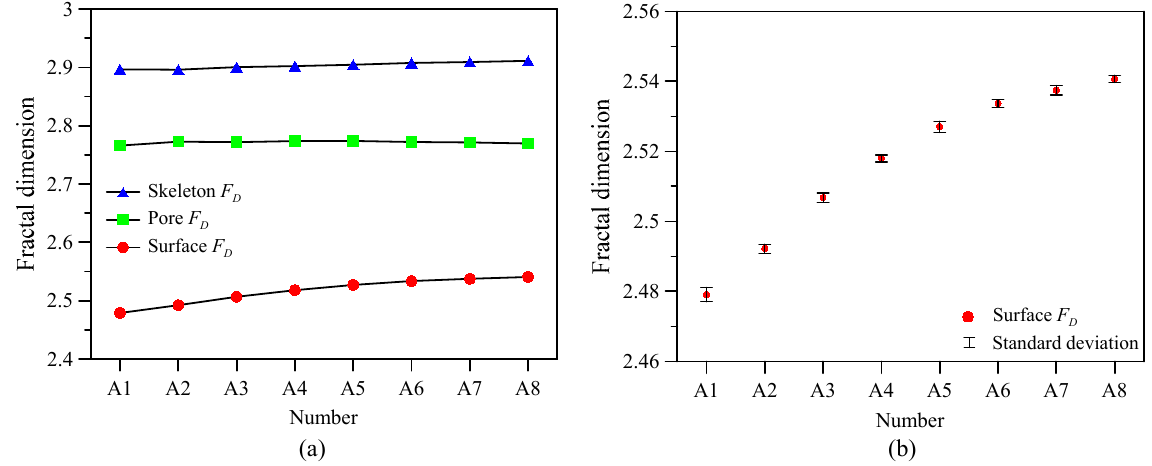
Figure 6. Fractal dimension evolution of sedimentation model. ( a ) Three kinds of fractal phases; ( b ) Surface fractal dimension and its standard deviation.